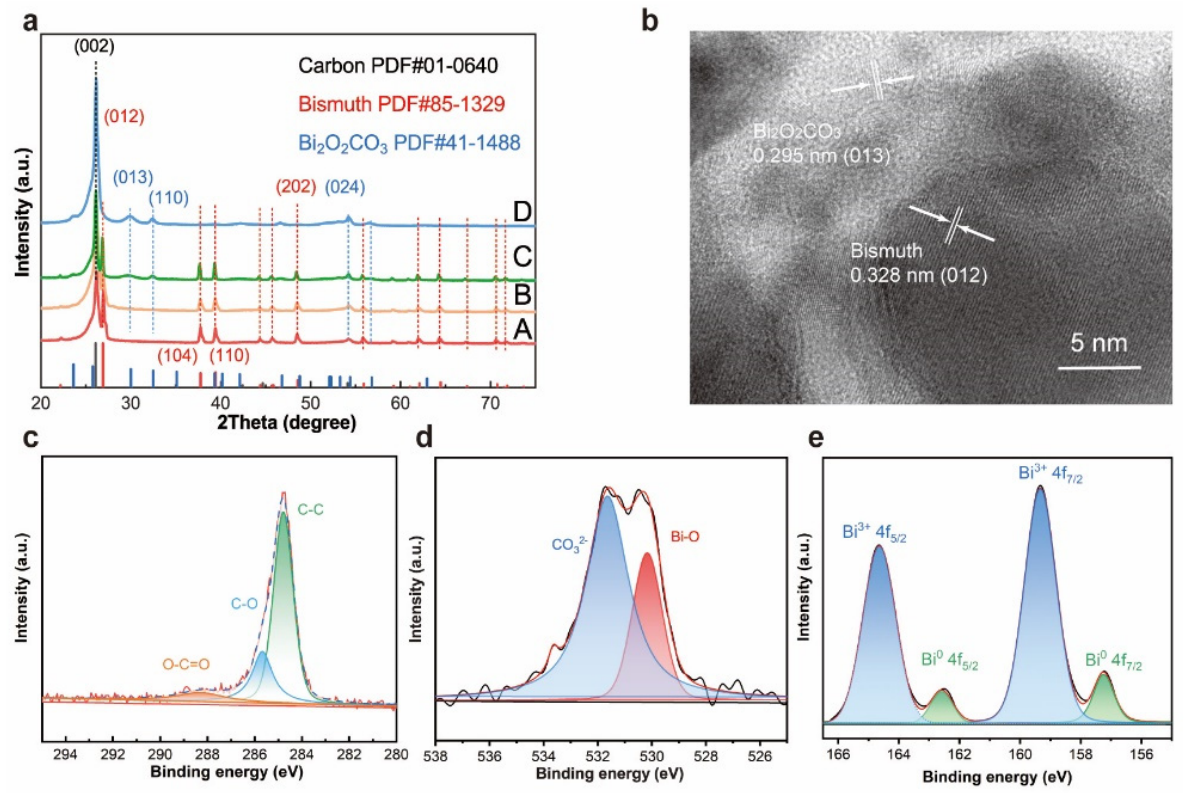
Figure 2. Characterizations of Bi 2 O 2 CO 3 @Bi/CP samples. ( a ) XRD pattern of the synthesized Bi/CP in EG solution. Curve A: sample A electrodeposited at 1.2 mA by PC method, Curve B: sample B electrodeposited at 0.8 mA by PC method and put in an argon atmosphere, Curve C: sample C and D electrodeposited at 0.8 mA and exposed in air for three days and more than seven days, individually. ( b ) High resolution TEM images of Bi 2 O 2 CO 3 @Bi/CP . ( c – e ) X-ray photoelectron spectroscopy (XPS) spectra: ( c ) C1s, ( d ) O1s and ( e ) Bi 4f.